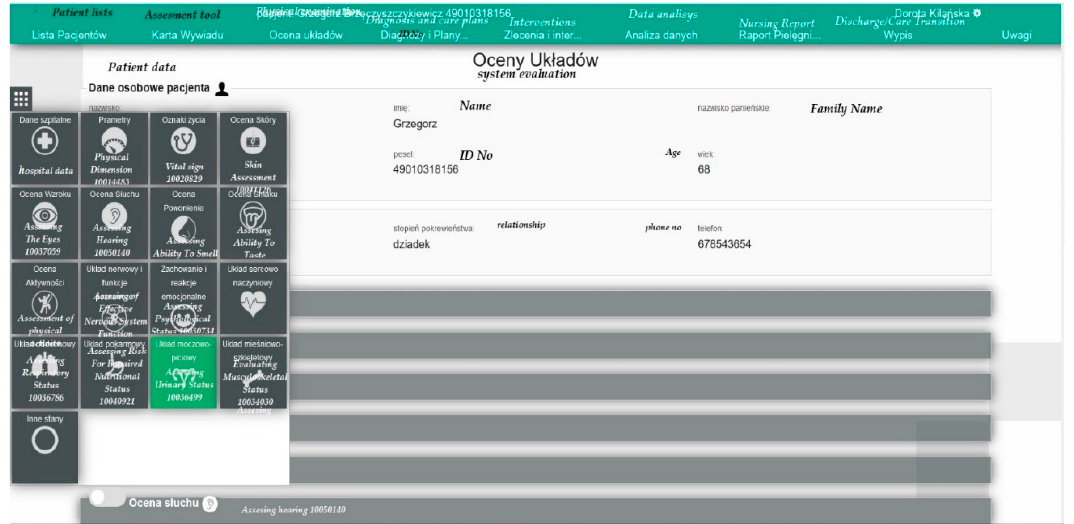
Figure 4. Iconography of physical examination in ADPIECare “Dorothea” using ICNP TM print screen; source: https://pielegniarki.umed.pl/oceny.html (accessed on on 19 April 2022).